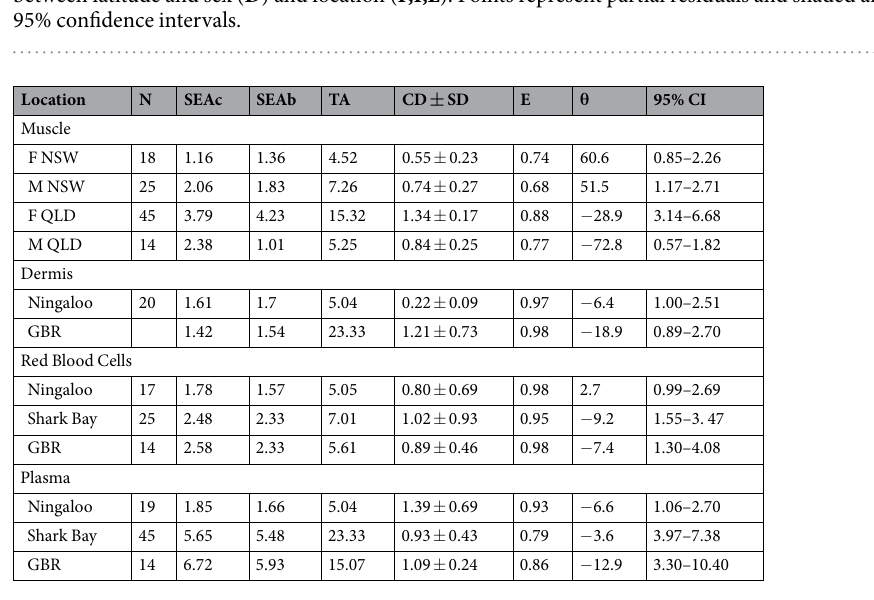
Table 2. Isotopic niche area described by Standard Ellipse Area (SEAc) (‰), Bayesian SEAb and parameters; N = number of samples, TA = total area of the convex hull, CD = mean centroid distance and standard deviation (SD), E = eccentricity, θ = angle of ellipse and CI = confidence interval. F = Females, M = Males, QLD = Queensland Shark Control Program and GBR, GBR = Great Barrier Reef and NSW = New South